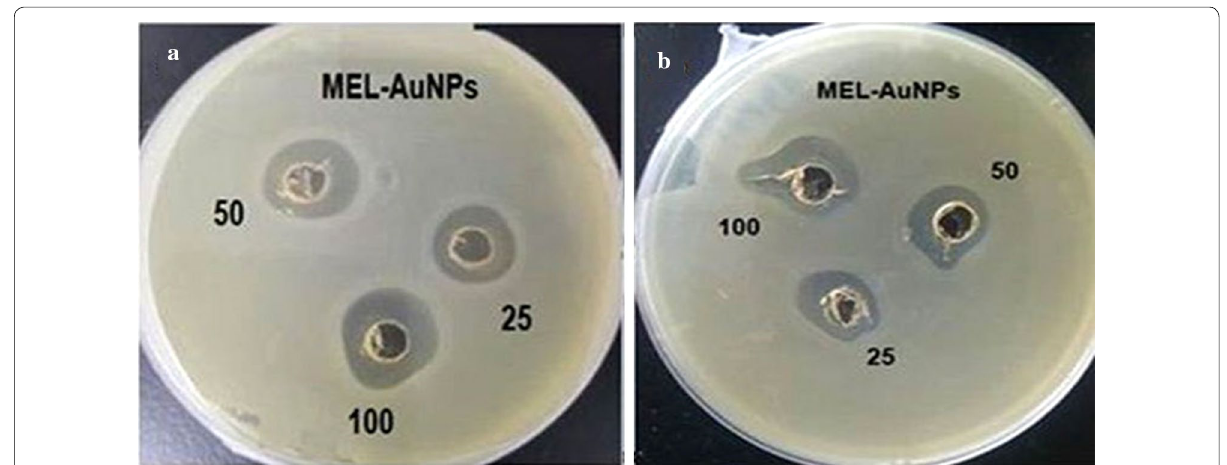
Fig. 5 Antibacterial activity of biosynthesized MEL-AuNPs against a Escherichia coli and b Staphylococcus aureus